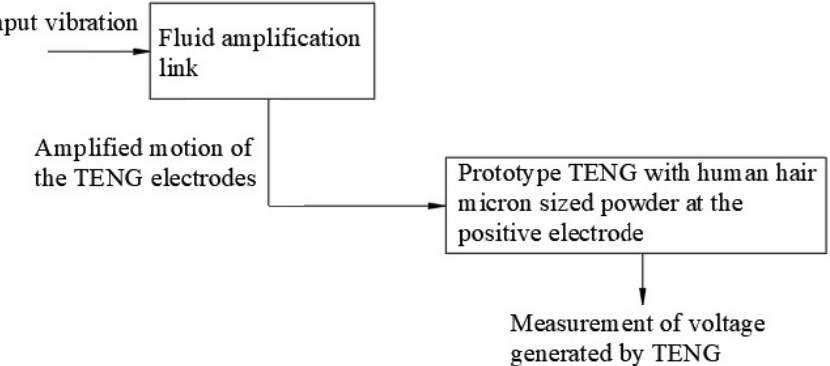
Figure 1. Block diagram for working of the prototype energy harvester.